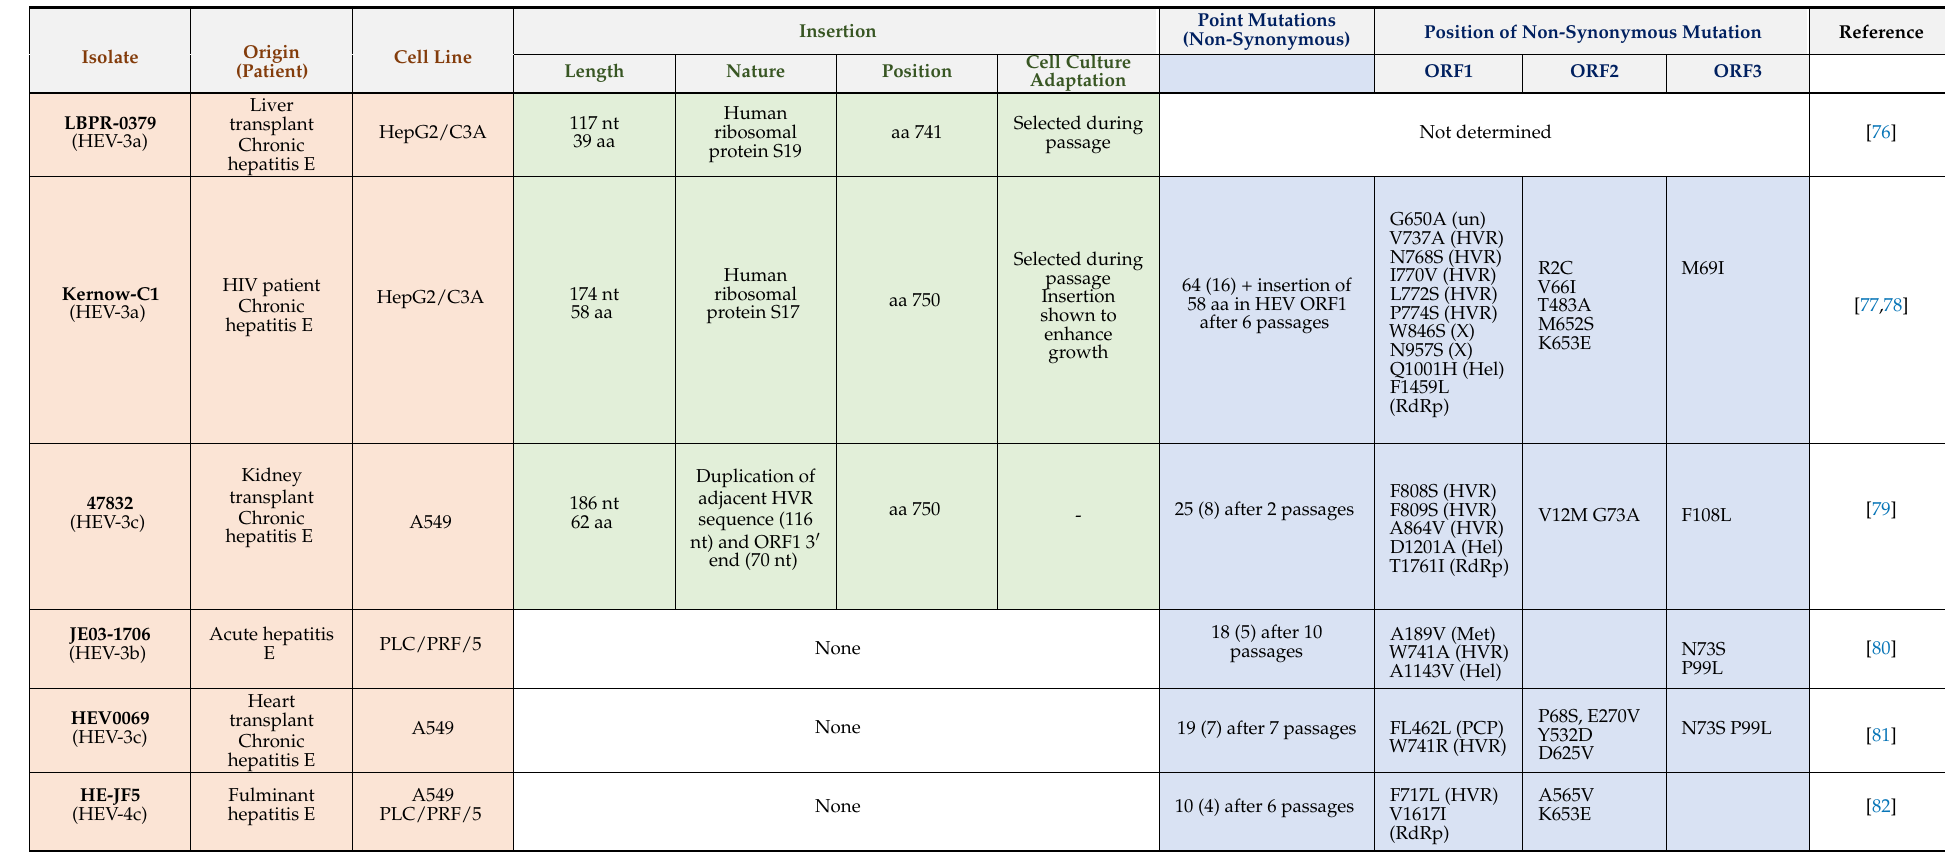
Table 3. HEV clinical isolates passaged several times in cell culture. Details of the name, origin of the isolate and infected cell line are given (pink fields). The presence of an insertion within the HVR is highlighted in green and its length, nature and position within the genome indicated. When determined, details of mutations identified within the HEV genome after several passages in cell culture are given (blue fields). nt: nucleotide; aa: amino